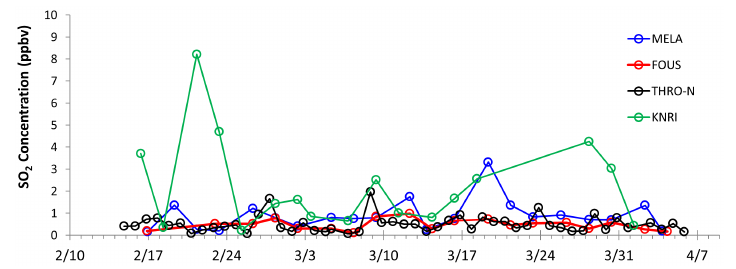
Figure 5. URG measurements of SO 2 from all of the field sites during the first study period.